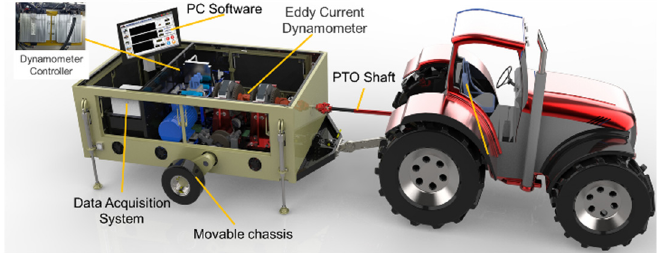
Figure 4. The structure principal diagram of tractor PTO loading test bench.